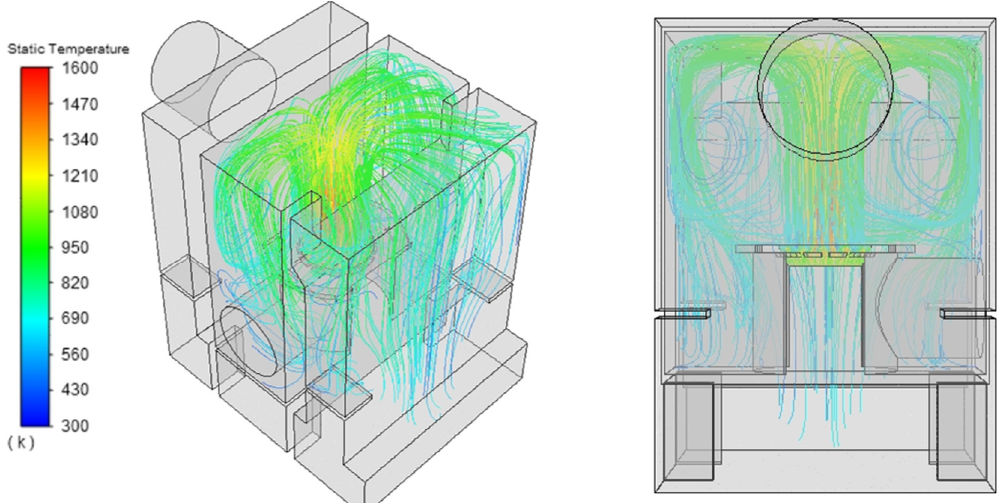
Figure 7. Gas particle paths—temperature scale (K).